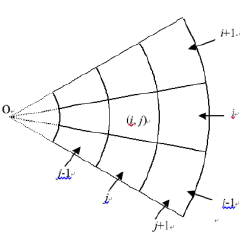
Figure1. The analysis volume point and its neighbour points As shown in Fig. 1, the wind shear was calculated by making a comparison of the center point with 8 neighbour grids. The maximum gradient value of the velocity difference on unit length was selected to present wind shear magnitude. The value of wind shear is calculated on unit length as